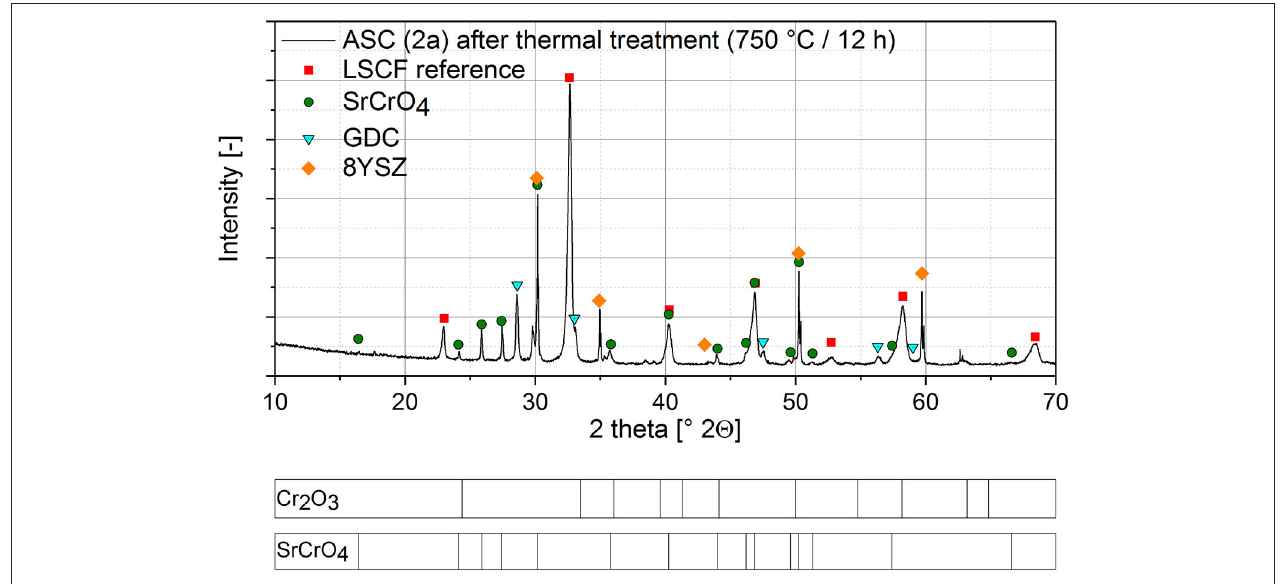
FIGURE 1 | XRD analysis of a single cell after Cr poisoning via solid phase poisoning and thermal treatment for 12h at 750 ◦